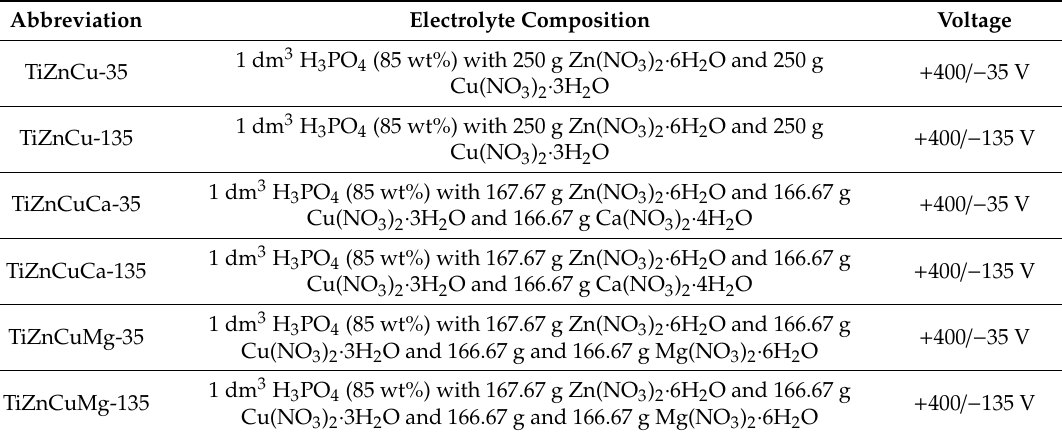
Table 3. Abbreviated samples’